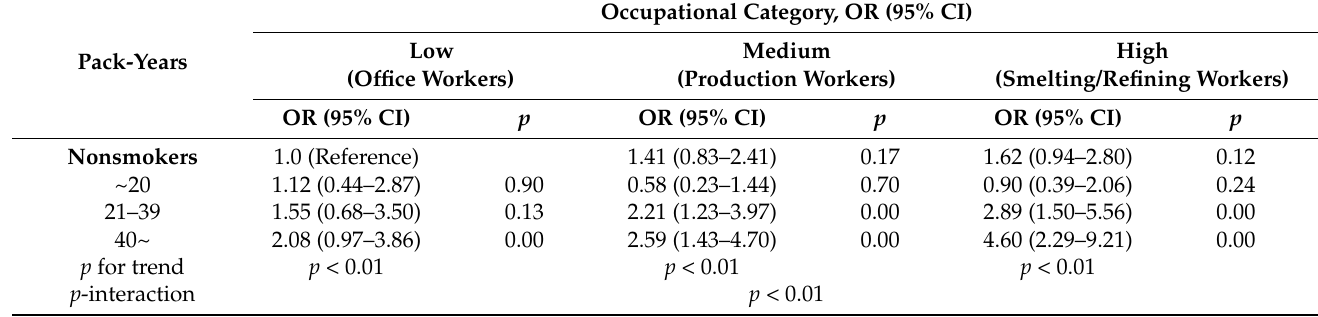
Table 5. Multiplicative interaction between metal and smoking exposure for prevalence of COPD within the Jinchang Cohort Study